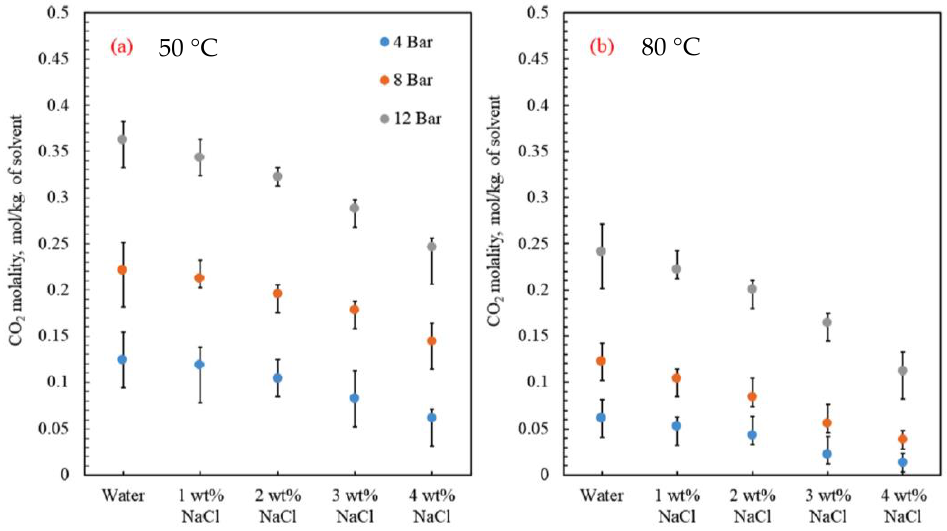
Figure 5. CO 2 molality results for different salinities (0 – 4 wt% NaCl); ( a ) 50 °C; ( b ) 80 °C [8].